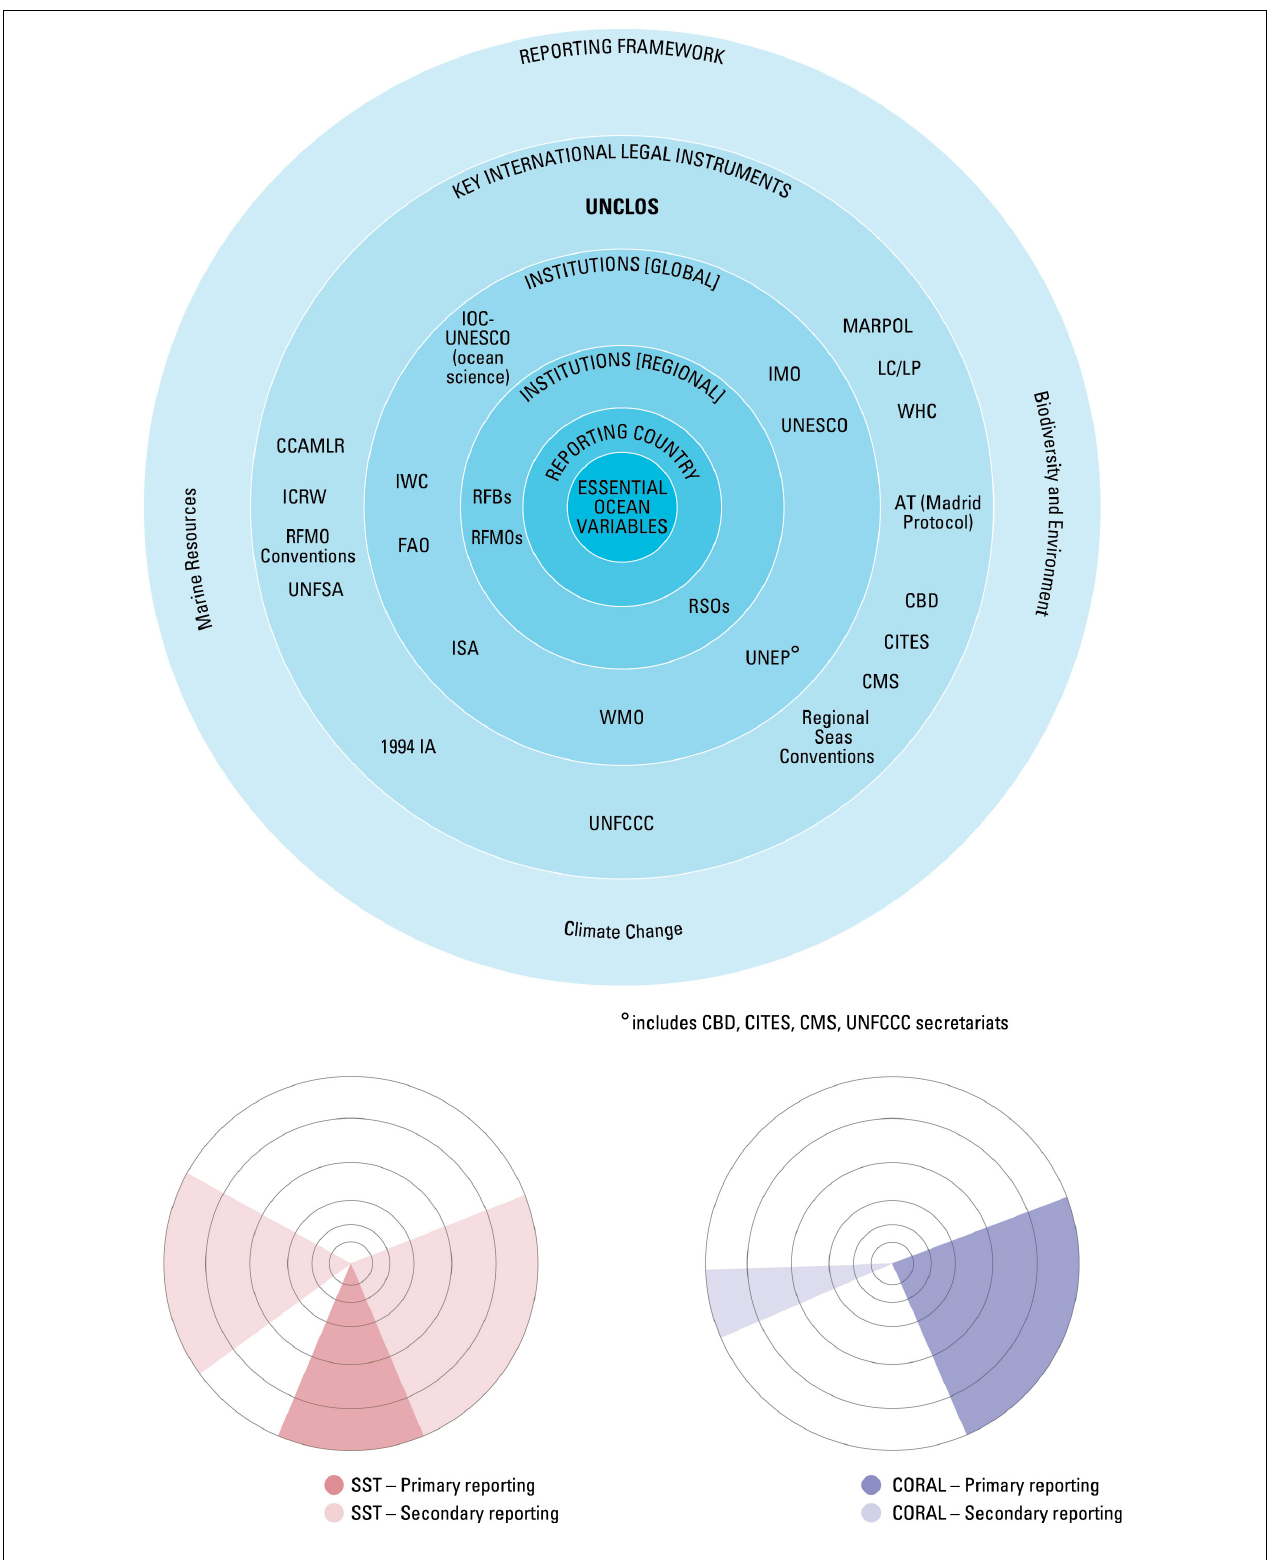
FIGURE 4 | An illustration of the many international instruments, legal instruments, and reporting frameworks that the GOOS EOVs deliver to. The smaller plots indicate the primary and secondary delivery areas for the sea surface temperature and coral cover and health EOVs (from Bax et al., 2018).